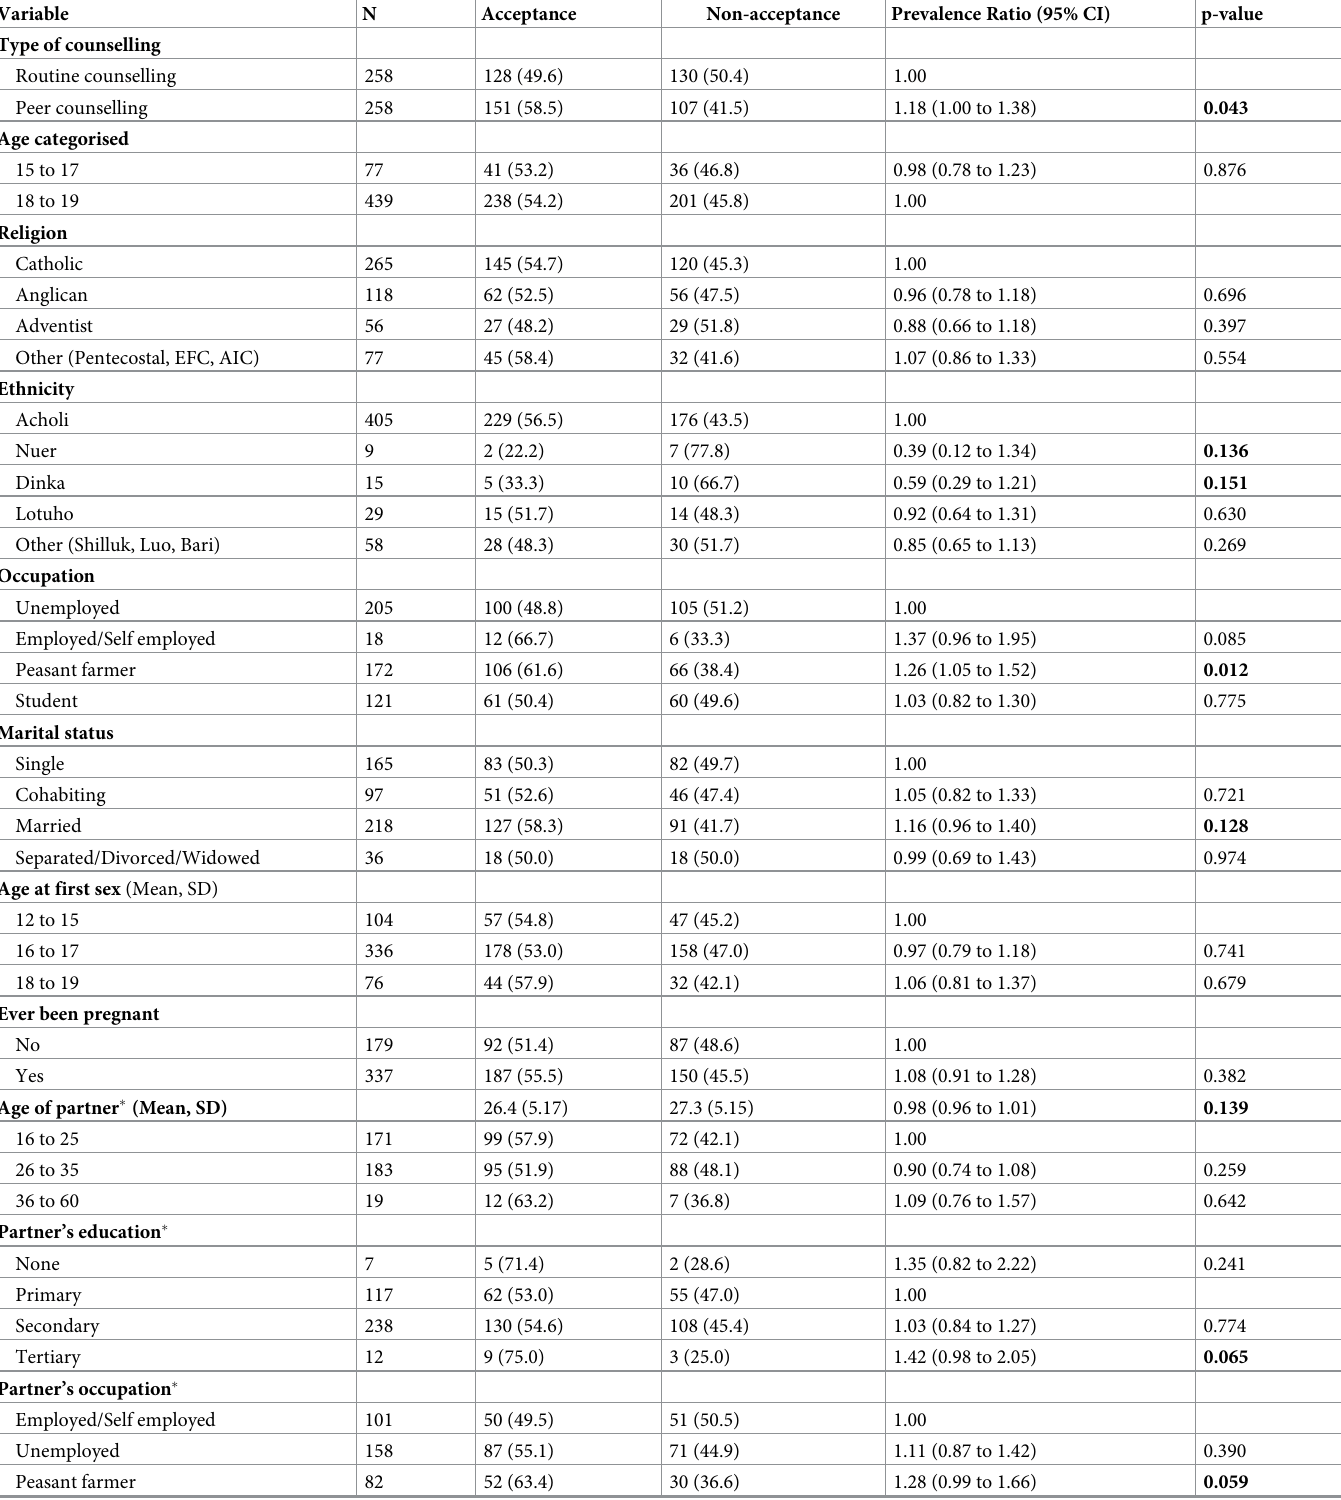
Table 3. Bivariate